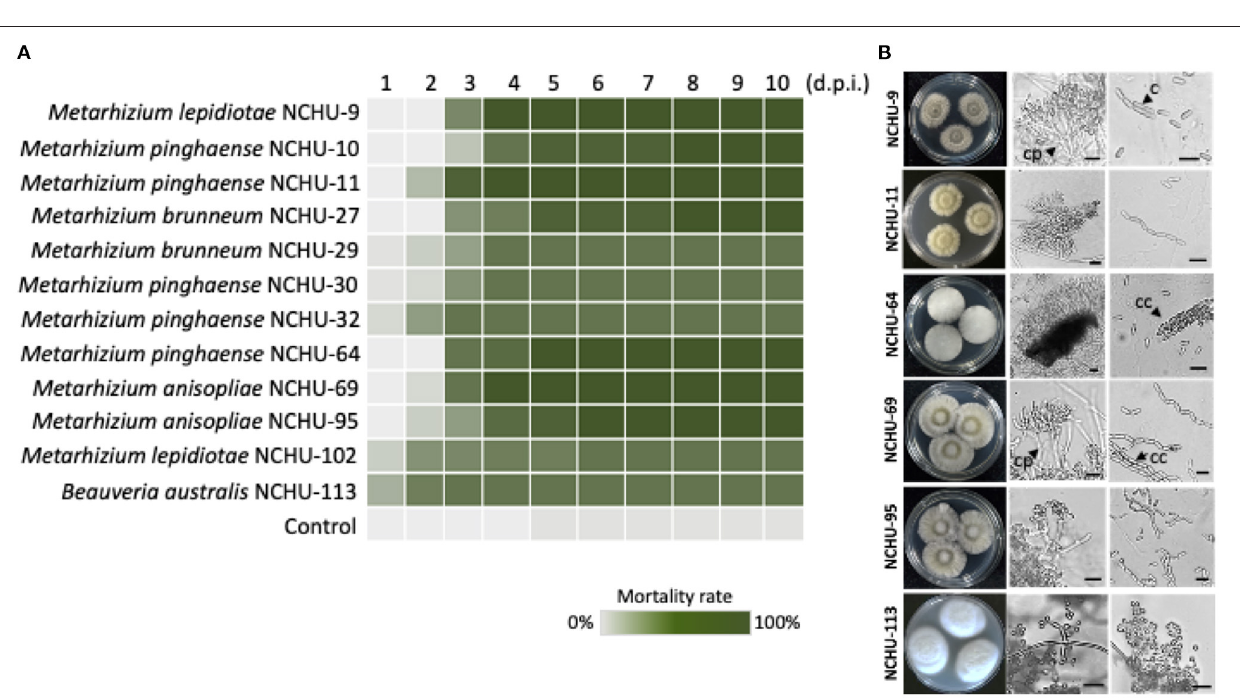
FIGURE 4 | The phylogenetic trees were constructed using the ML, ME, and NJ analyses method based on the fungal transcriptional elongation factor 1 alpha ( tef ) for (A) 11 promising Metarhizium spp. and (B) one Beauveria sp. in MEGA7. Bootstrap analyses were performed to evaluate the robustness of the phylogenies using 1000 replicates and the bootstrap values > 50% for ML, ME, and NJ trees at each node (ML/ME/NJ). The arrows indicated the promising fungal isolates from this study.